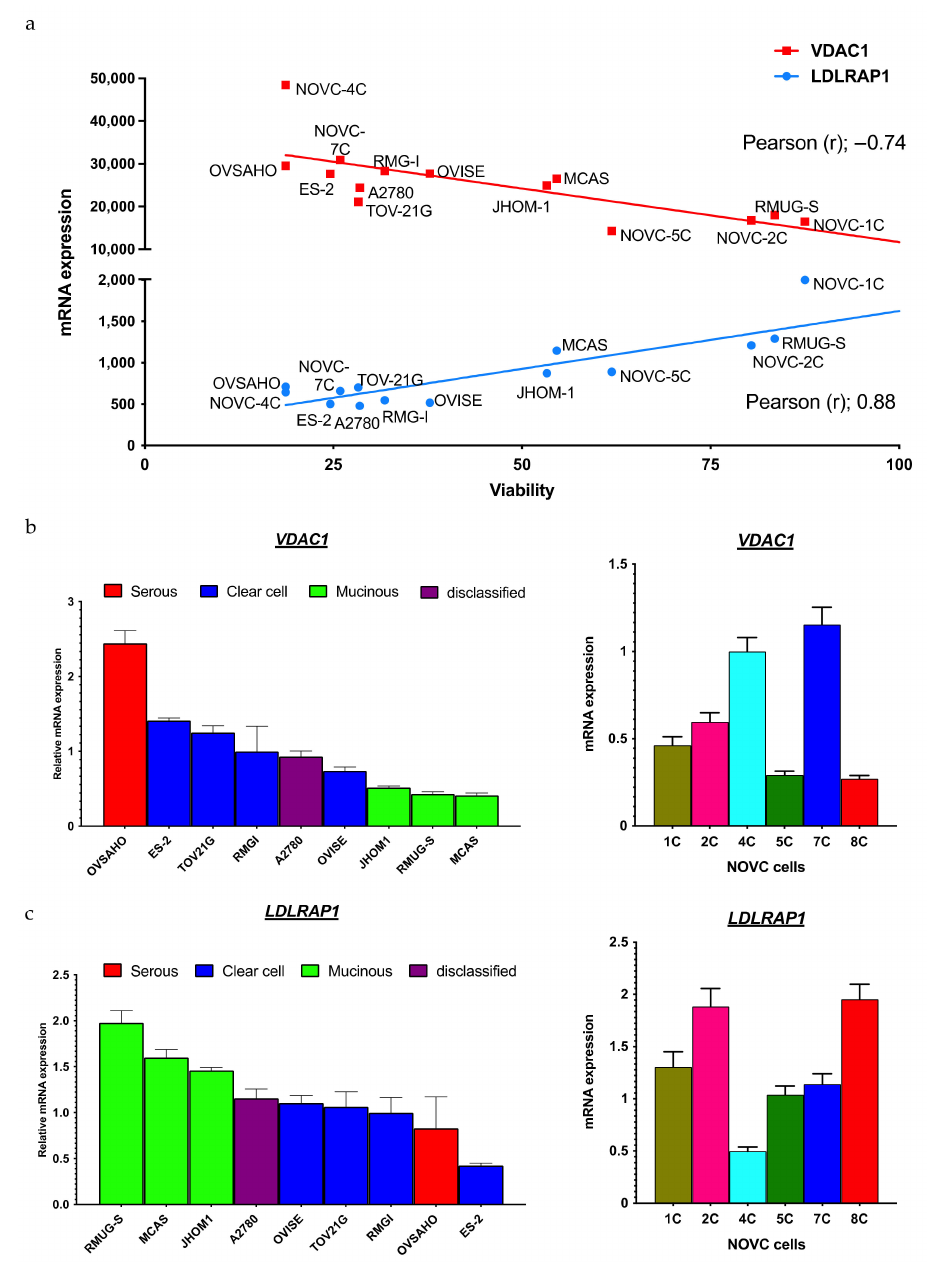
Figure 3. Establishment of a biomarker to predict response to statins in ovarian cancer. ( a ) VDAC1 and LDLRAP1 were identified from existing ovarian cancer cell lines and human ovarian cancer ascites- derived cell lines using microarray analysis. mRNA expressions were calculated by normalization of fluorescence intensity of VDAC1 and LDLRAP1 to those of the reference gene ACTB . Pearson’s correlation coefficient (r) was calculated from gene expression and cell viability following simvastatin administration. VDAC1 was positively correlated with simvastatin response, and LDLRAP1 was negatively correlated with simvastatin response. ( b ) Validation of VDAC1 expression in nine existing ovarian cancer cell lines (A2780, ES-2, JHOM1, MCAS, OVISE, OVSAHO, RMG-1, RUMG-S, and TOV-21G) and human ovarian cancer ascites-derived cell lines (NOVC-1C, 2C, 4C, 5C, 7C, and 8C). The mRNA expression in each cell was normalized to ACTB expression ( n = 3). ( c ) Validation of LDLRAP1 expression in nine existing ovarian cancer cell lines (A2780, ES-2, JHOM1, MCAS, OVISE, OVSAHO, RMG-1, RUMG-S, and TOV-21G) and the cell lines established from human ovarian cancer ascites (NOVC-1C, 2C, 4C, 5C, 7C, and 8C). The mRNA expression in each cell was normalized to ACTB expression ( n =